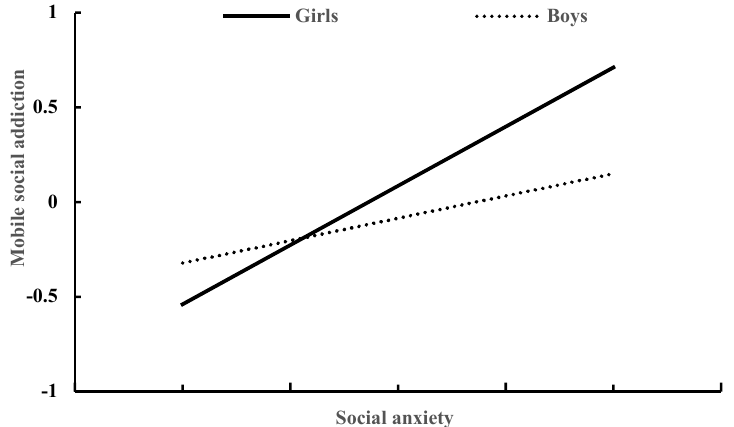
Figure 3. The relationship between social anxiety and mobile social addiction in girls and boys.